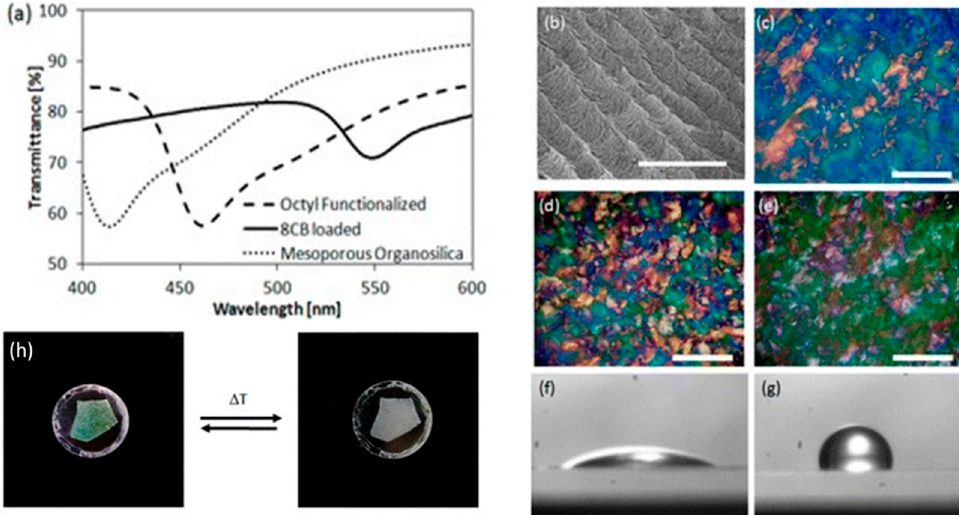
Figure 7. ( a ) UV − vis spectra of the mesoporous organosilica film, the octyl-functionalised organosilica film, and the octyl-functionalised organosilica film loaded with 8CB. ( b ) SEM image of the host material showing the characteristic left-handed twist of the layers (scale bar, 2 µm). ( c – e ) POM images of the mesoporous organosilica film, the octyl-functionalised organosilica film, and the 8CB loaded octyl-functionalised organosilica film, respectively, viewed under crossed polarisers (scale bar, 300 µm). Contact angle images of a drop of water on ( f ) the mesoporous organosilica and ( g ) the octyl-functionalised organosilica. ( h ) Thermochromic behaviour of the octyl-functionalised organosilica film loaded with 8CB, showing colour change from green to colourless upon heating to 48 °C. Reprinted with permission from Giese et al., ACS Appl. Mater. Interfaces 2013 , 5 , 6854–6859.